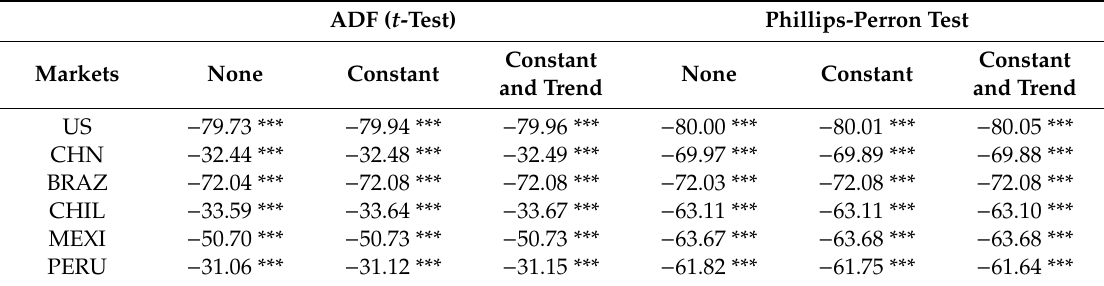
Table 2. Unit root